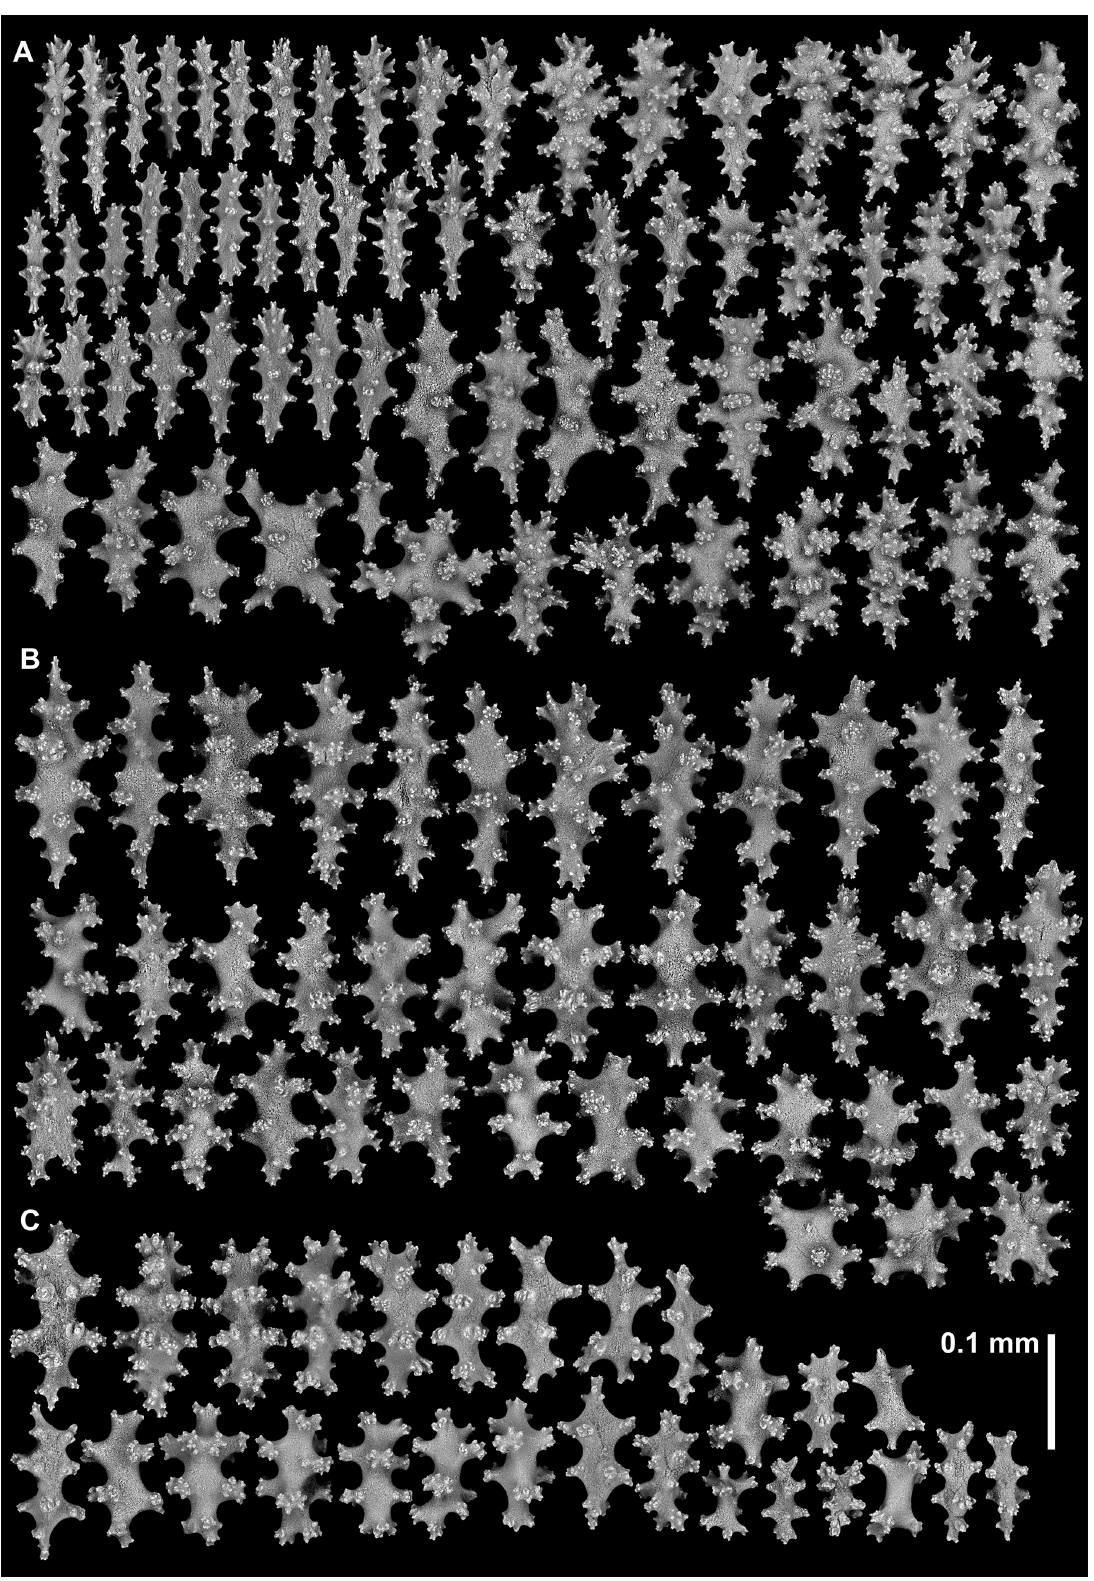
Fig. 33. Ushanaia fervens gen. et sp. nov., holotype (NIWA 156311), SEMs of sclerites. A . Polyp mound. B . Surface (of thick, fleshy areas of colony). C . Interior (of thick, fleshy areas of